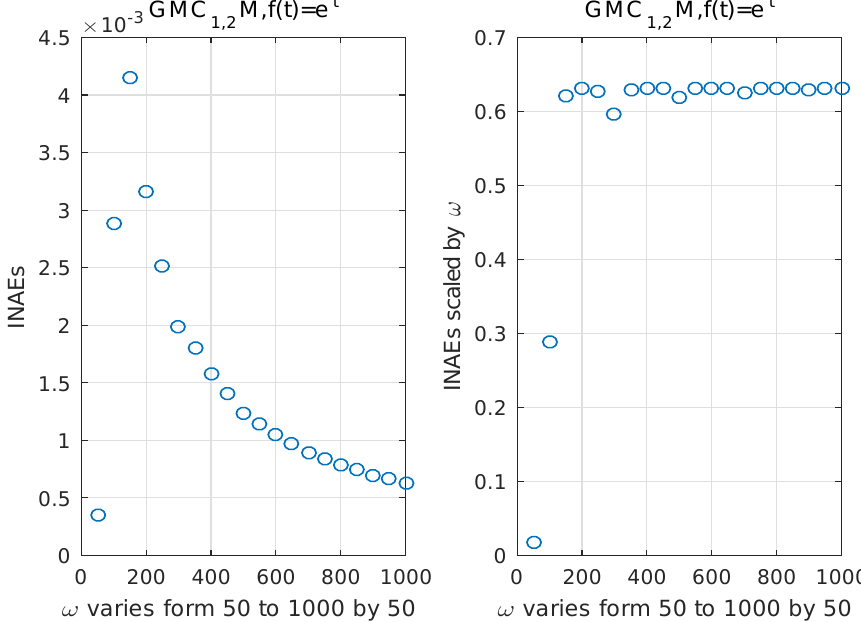
M for the highly oscillatory Figure 4. GMC k 1 , k 2